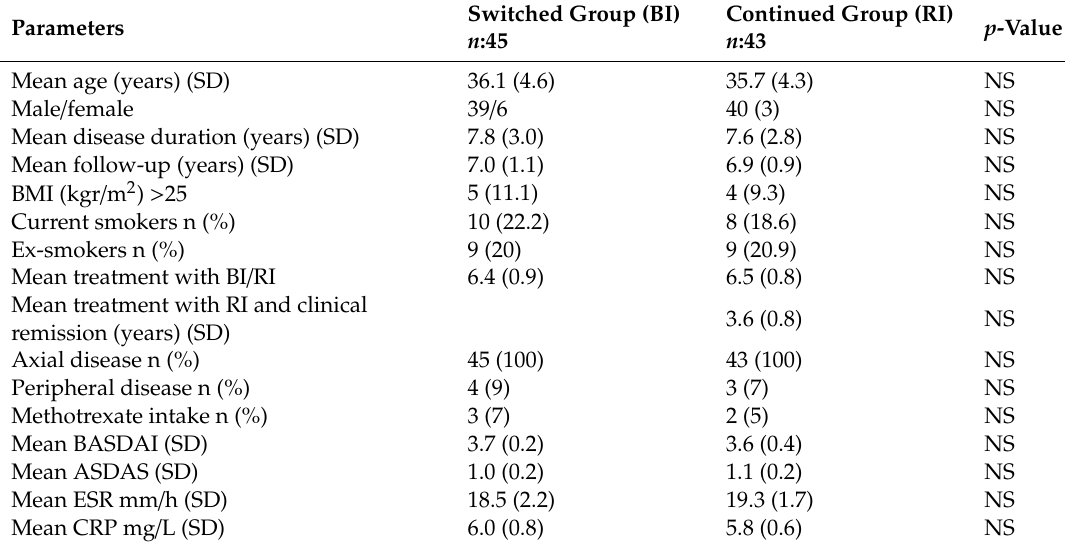
Figure 1. Flow chart of AS patients treated with infliximab. Table 1. Demographic and clinical characteristic of Ankylosing Spondylitis (AS) patients at